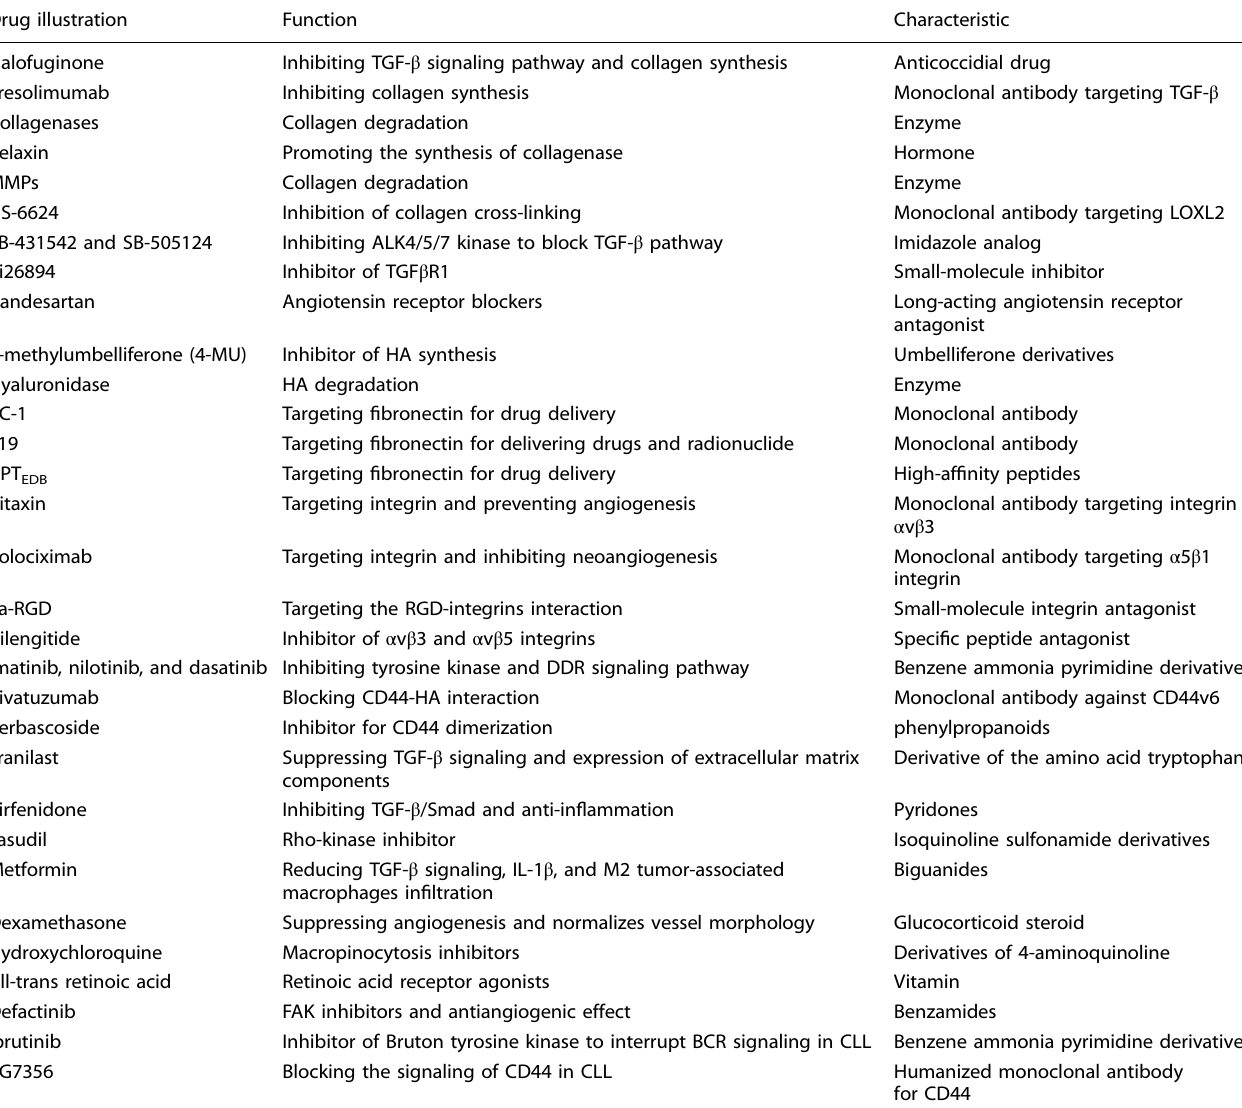
Table 1. ECM as a therapeutic target in cancer Drug illustration